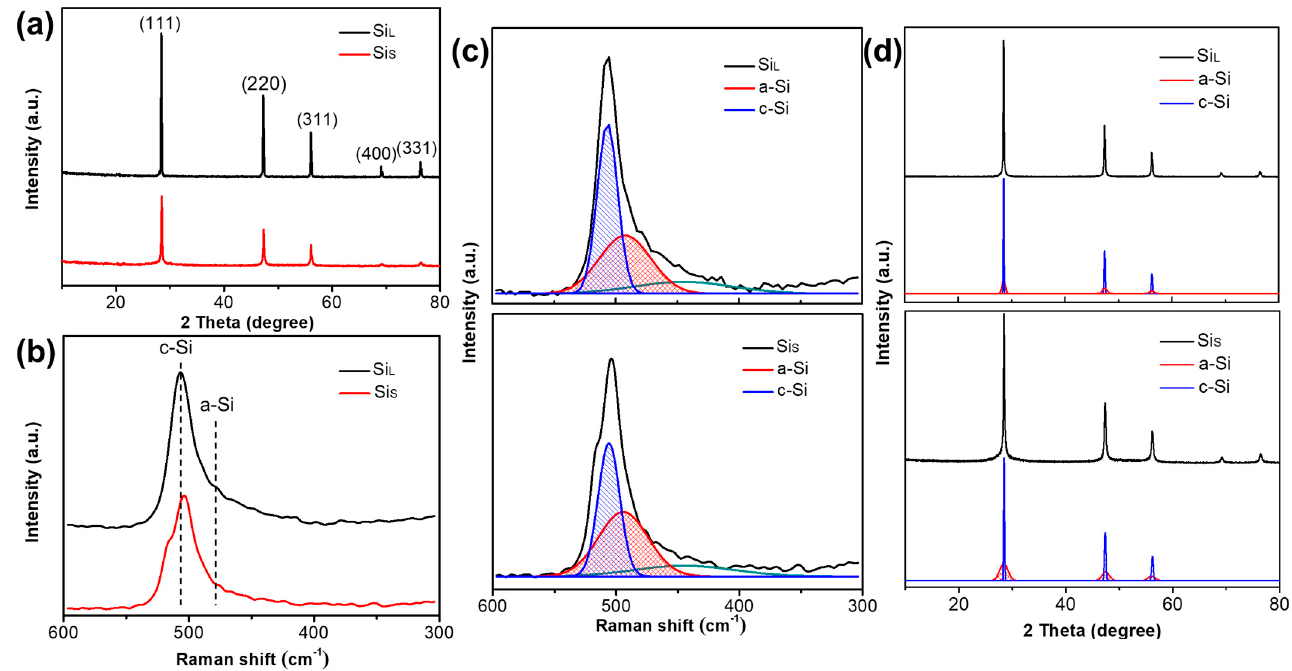
Figure 8. ( a ) X-ray diffraction patterns, ( b ) Raman spectrum, ( c ) Raman spectrum fitting and ( d ) XRD pattern fitting of Si L and Si S .